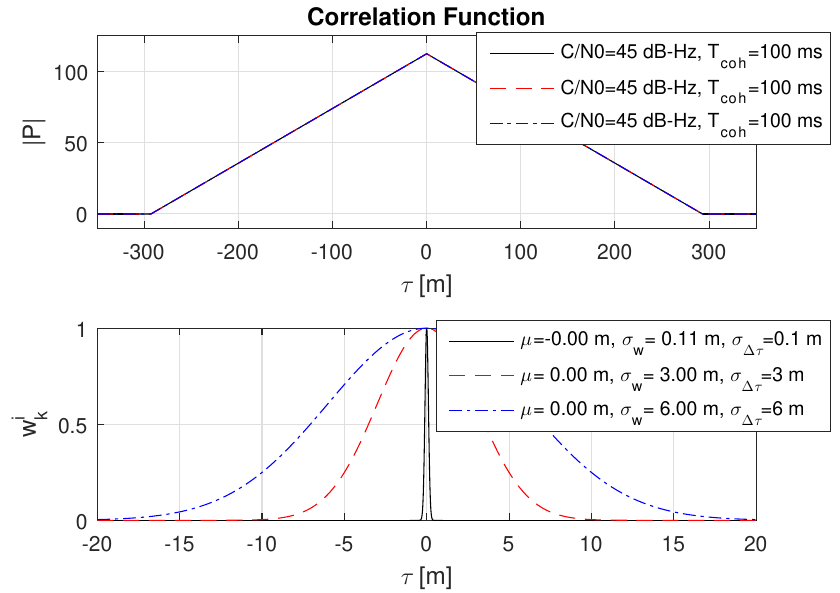
Figure 8. Impact of different code delay bias standard devications σ ∆ τ on the weights w i integration time T coh = 100 ms. It can be seen that σ w now approaches the theoretical limits for all σ ∆ τ . Note also the significantly changed amplitude on | P |